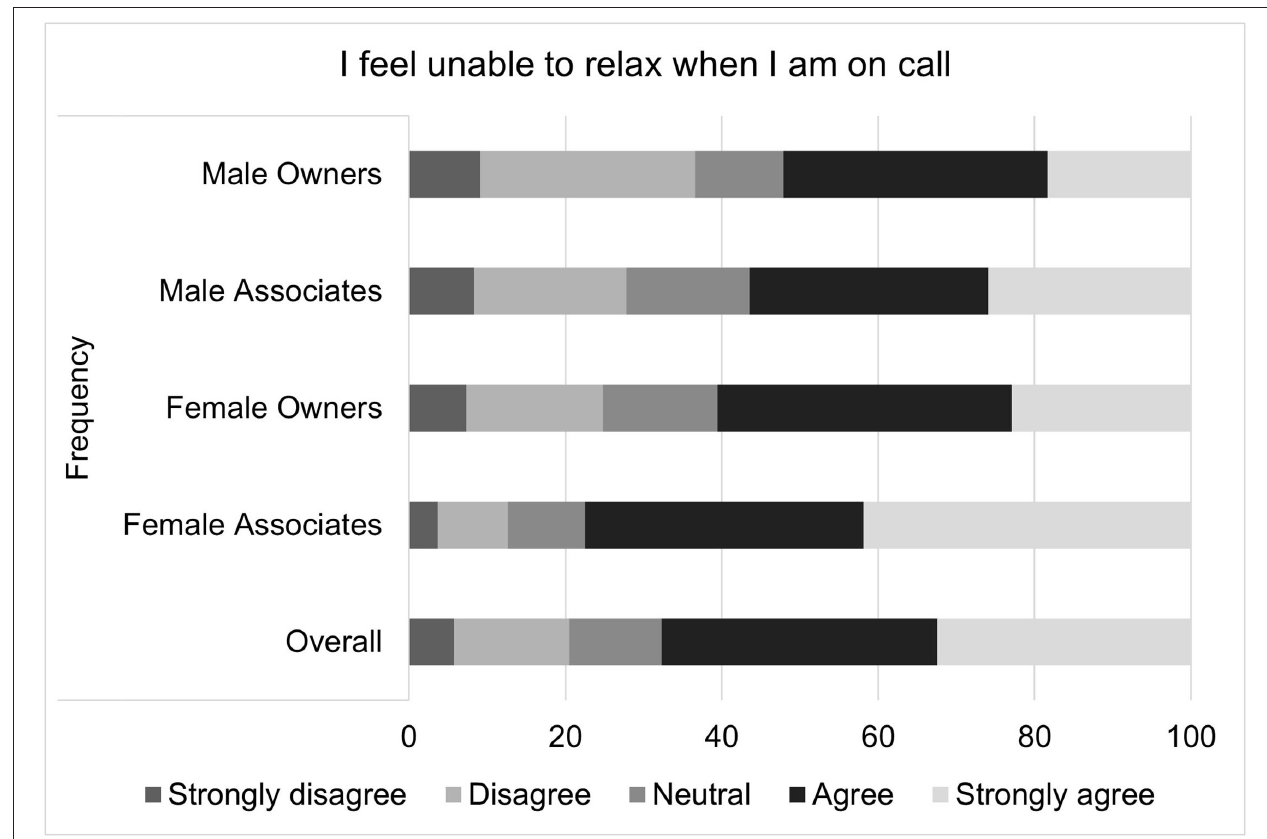
FIGURE 9 | Sleep difficulties while on-call, as reported by male and female practice owners and associate veterinarians.